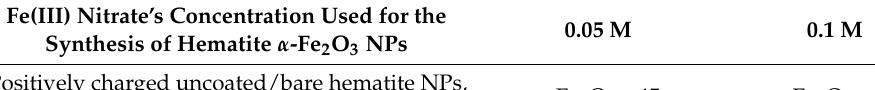
Table 2. Designation of synthesized hematite ( α -Fe 2 O 3 ) NPs based on their primary size and surface